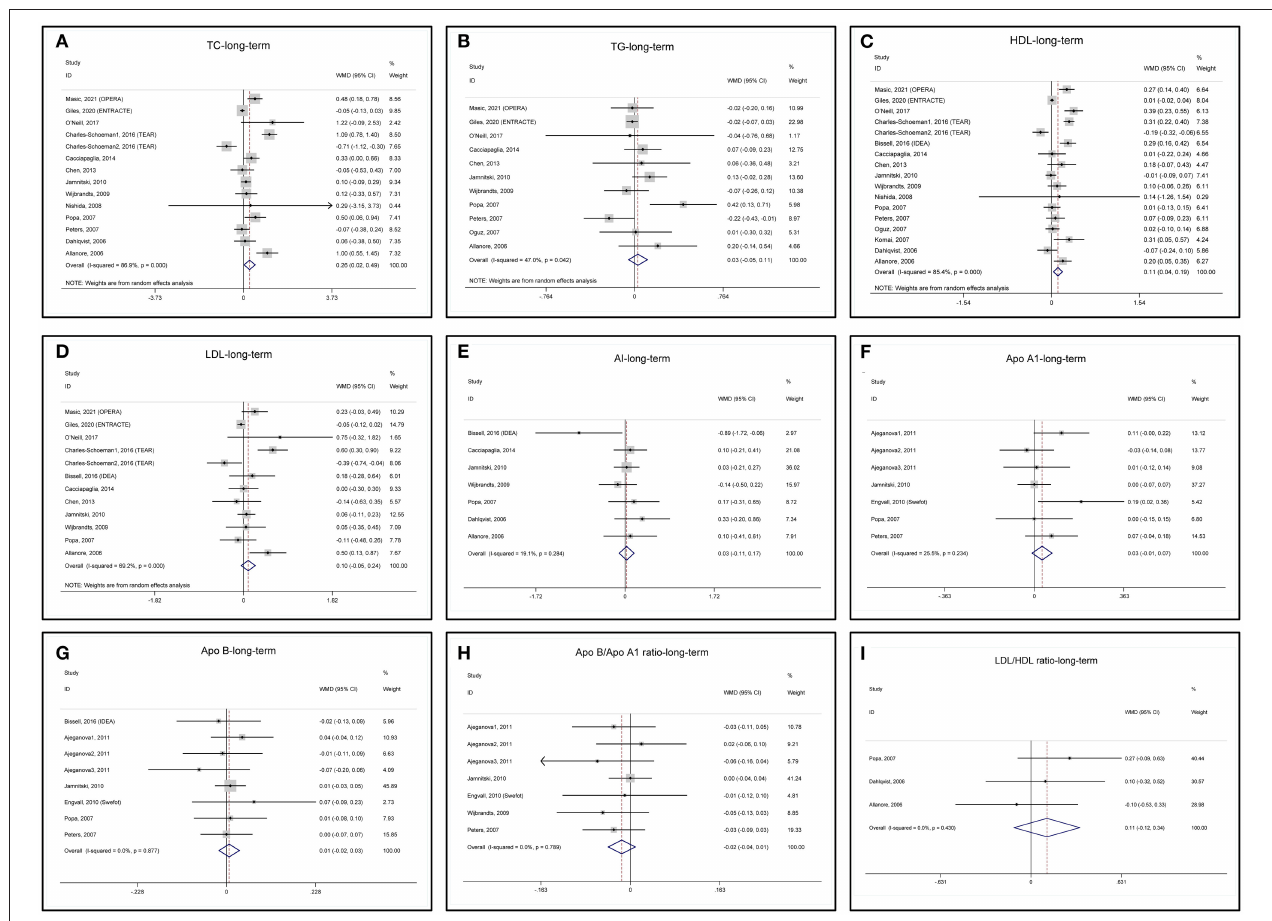
FIGURE 4 | Forest plots of meta-analyses of the long-term changes in (A) TC, (B) TG, (C) HDL, (D) LDL, (E) AI, (F) ApoA1, (G) ApoB, (H) ApoB/ApoA1 ratio, and (I) LDL/HDL